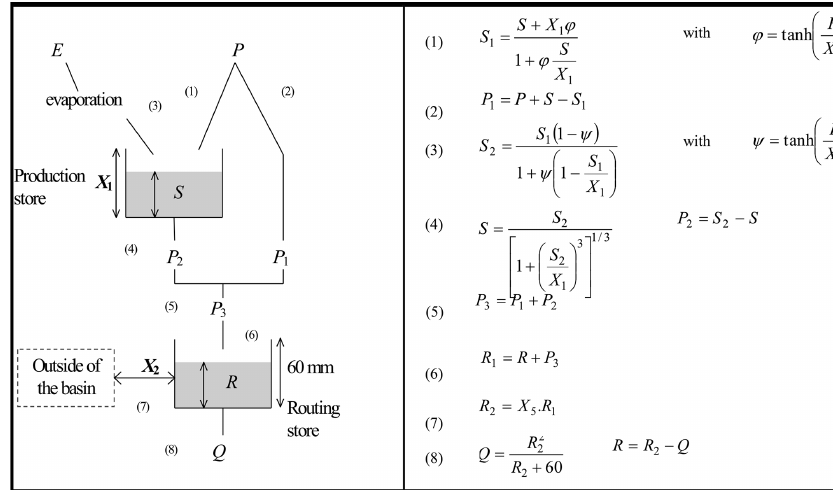
Figure 4. Architecture of the GR2M model (Mouelhi et al., 2006).